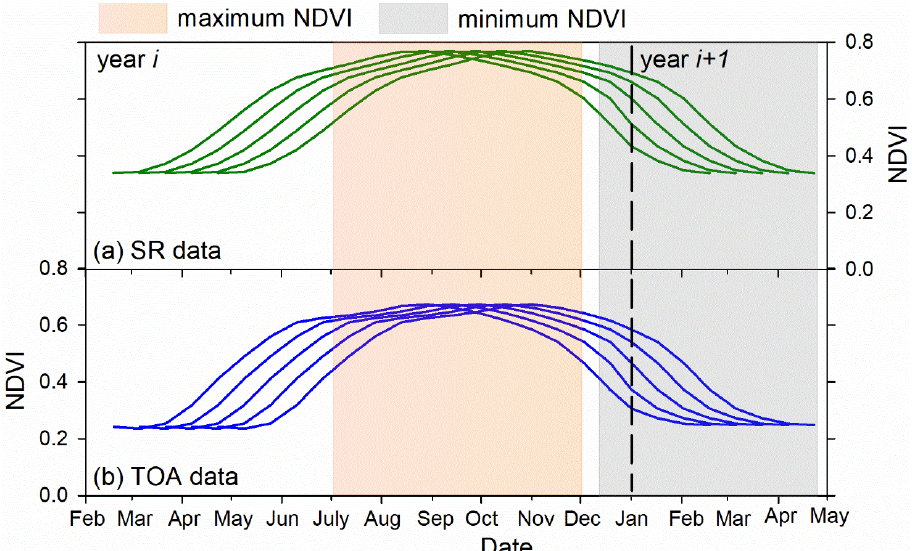
Figure 4. Multiple standard NDVI curves for sugarcane in China for both SR and TOA data. The orange areas are the periods used to calculate maximum NDVI (NDVI max ) in sugarcane grand growth period and the grey areas are the periods used to calculate the minimum NDVI (NDVI min ) in sugarcane harvest season.